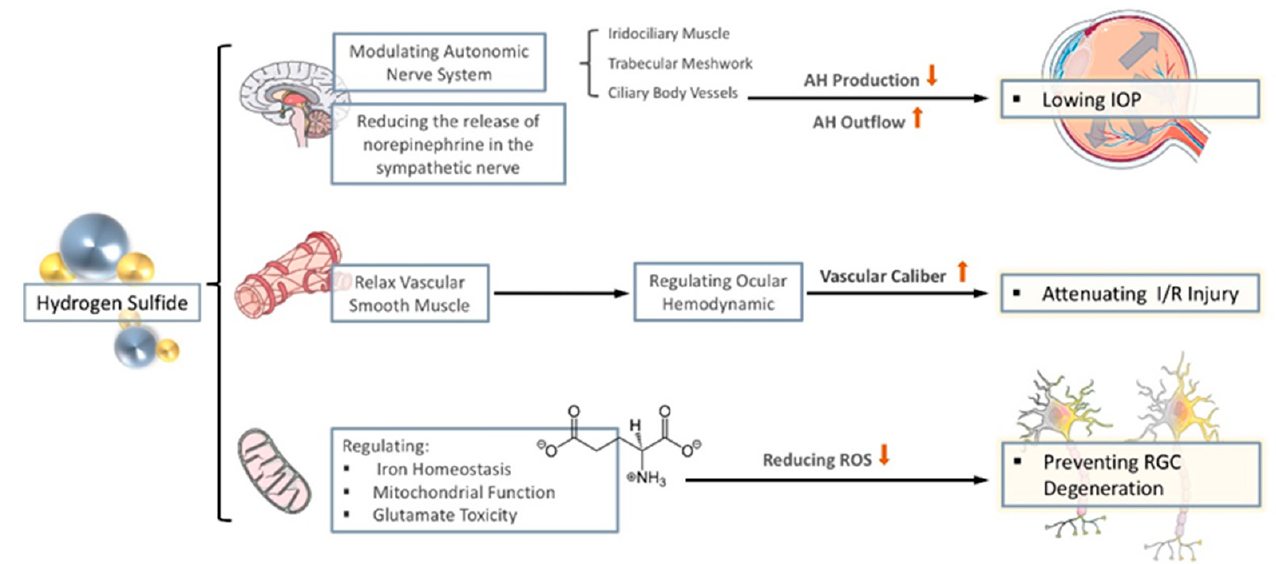
Figure 2. The anti-oxidative properties of H 2 S in glaucoma. The effect of H 2 S on glaucoma is mainly reflected in three aspects. (1) By regulating the autonomic nerves and reducing the release of sympathetic nerves, it reduces the production of aqueous humor (AH) and promotes the flow of AH to lowering intraocular pressure (IOP). (2) Through the relaxation of vascular smooth muscles, stabilize intraocular perfusion and reduce ischemia-reperfusion injury. (3) By regulating iron homeostasis, regulating mitochondrial function, and reducing the toxicity of glutamate, it reduces the generation of ROS to prevent nerve degenerative changes.